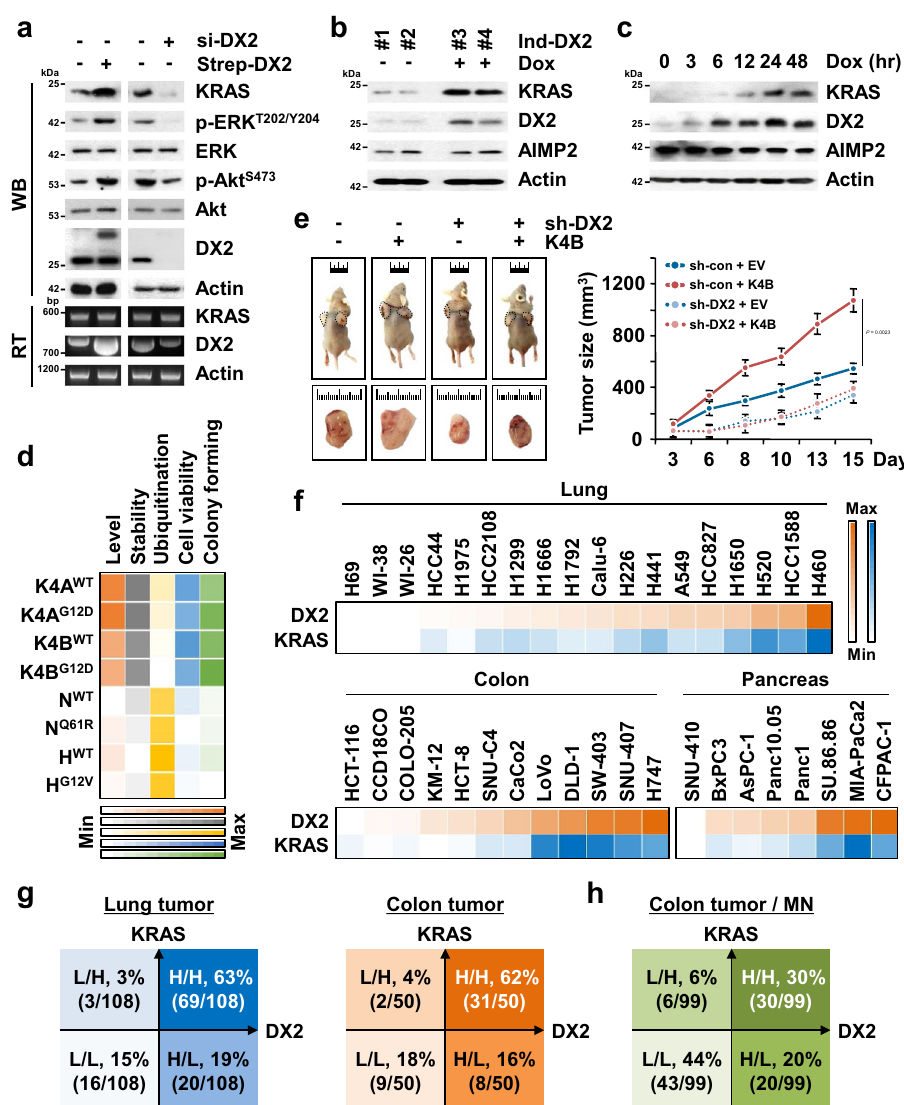
Fig. 1 Enhancement of KRAS protein stability by DX2. a DX2 levels in H460 lung cancer cells were controlled by the introduction of Strep-DX2 and si- DX2. Protein and mRNA levels were determined by Western blotting (WB) and RT-PCR (RT), respectively. Phosphorylation of ERK and Akt was monitored for KRAS signaling. Actin was used as a loading control. Results are representative of at least three independent experiments. b KRAS level in doxycycline (Dox)-inducible DX2 transgenic mice (Ind-DX2). Levels of KRAS and DX2 in colorectal tissues from two controls (#1, 2) and two Dox-fed mice (#3, 4) were analyzed. c MEF isolated from Ind-DX2 were treated with Dox in a time-dependent manner and protein levels were determined. Results are representative of at least three independent experiments. d Heat map from the results showing DX2-dependent regulation of RAS isoforms. DX2-mediated changes in the levels, stability, and ubiquitination of isoforms were quanti fi ed from Supplementary Fig. 1c – e. Cell viability and anchorage-independent colony formation assay were quanti fi ed from Supplementary Fig. 1g, h. Maximum (max) and minimum (min) values from the indicated experiments were designated as different colors with the highest and lowest intensity, respectively, and the rests were graded according to their relative values. e Result of xenograft ( n = 4) using H460 cells stably expressing the indicated combination of KRAS4B and sh-DX2. Representative images of mice and tumors for each group (left) and tumor sizes (right) were shown. Sh means short hairpin RNA. All error bars represent the standard deviation (S.D.). P value is from the two-sided t test. f Heat map representing the cellular levels of DX2 and KRAS in 18 lung, 12 colorectal and 8 pancreatic cell lines. The cellular levels of DX2 and KRAS in the tested cell lines were represented as the heat map of orange and blue colors, respectively. The maximum and minimum values quantitated as described in Methods were shown with the highest and lowest color intensity, respectively, and the rests were graded according to their relative values. g Analysis of the levels of DX2 and KRAS in lung and colorectal tumor tissues. Staining intensities of the two proteins were classi fi ed as low (L) and high (H) (Supplementary Fig. 2e). Number of the analyzed tissue samples is shown in brackets. h DX2 and KRAS levels in the tumor and matched normal (MN) tissues from 99 patients with colorectal cancer. Depending on the levels in tumor compared to MN, samples were classi fi ed as H and L as compared to MN levels (Supplementary Fig. 2f). Source data are provided as a Source data fi expressed low levels of both proteins. These data were further patient tissues showed that 63% of lung cancer ( n = 69/108) and con fi rmed in matched tumor and normal tissues from patients with 62% of colon cancer ( n = 31/50) expressed high levels of DX2 and colorectal cancer ( n = 99), where 30% ( n = 30/99) of the patients KRAS proteins (Fig. 1g and Supplementary Fig. 2e). In contrast, expressed high levels of both proteins and 44% ( n = 43/99) only 15% and 18% of the lung and colon cancer tissues, respectively,